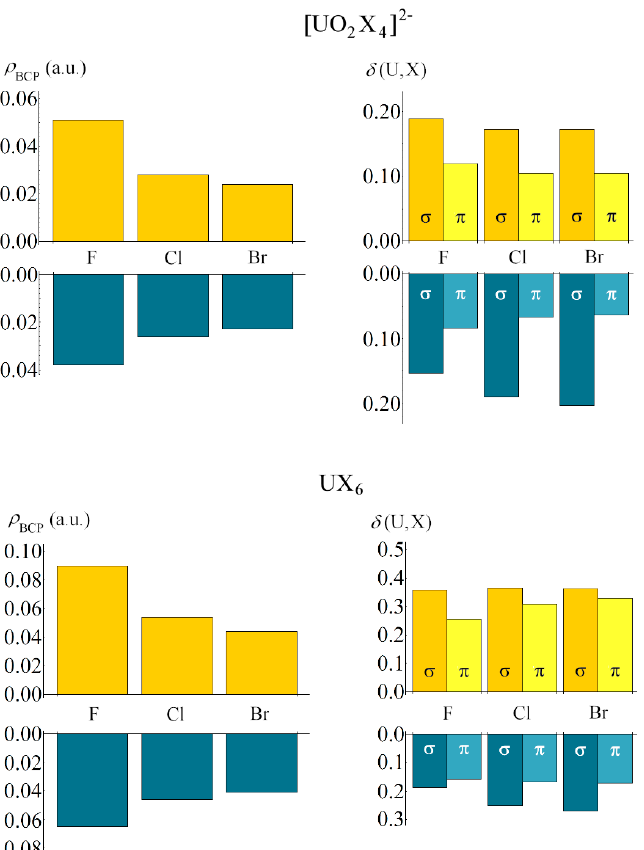
Figure 3. Decomposed QTAIM metrics of the U-X bond in [UO 2 X 4 ] 2 − and UX 6 complexes (X = F, Cl, Br) obtained from B3LYP-derived densities. f-shell contributions are given in yellow and d-shell contributions are in blue.